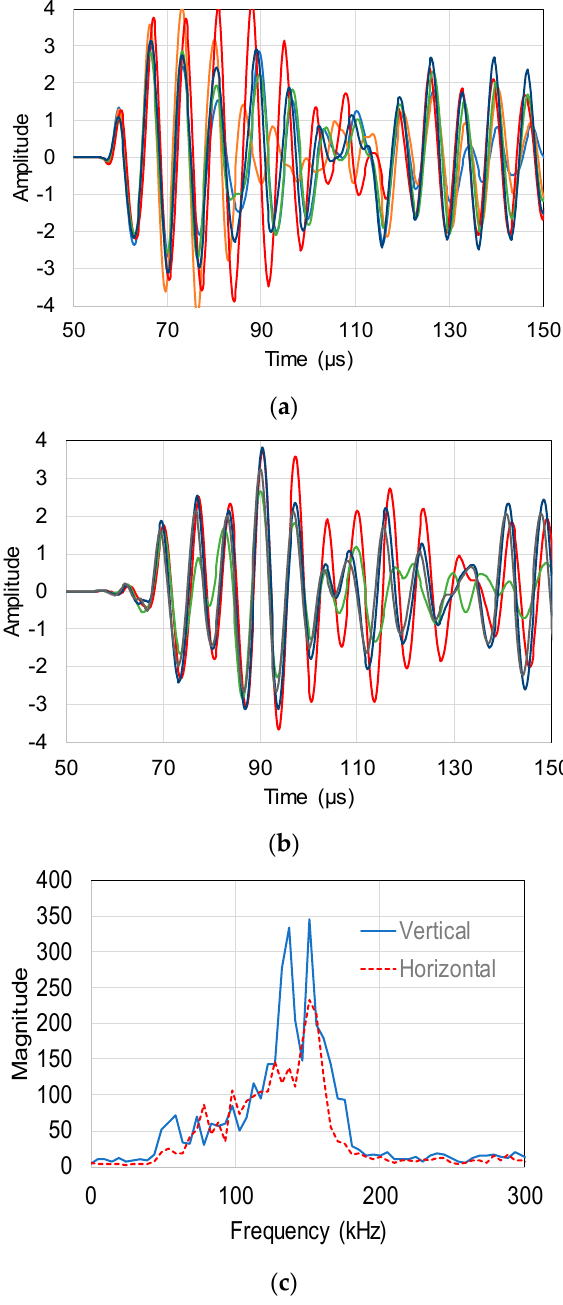
Figure 14. Waveforms received by long size (R15, 20 mm) sensor in the case of ( a ) horizontal surface; ( b ) vertical excitation; ( c ) The average FFT curves of previous waveforms.